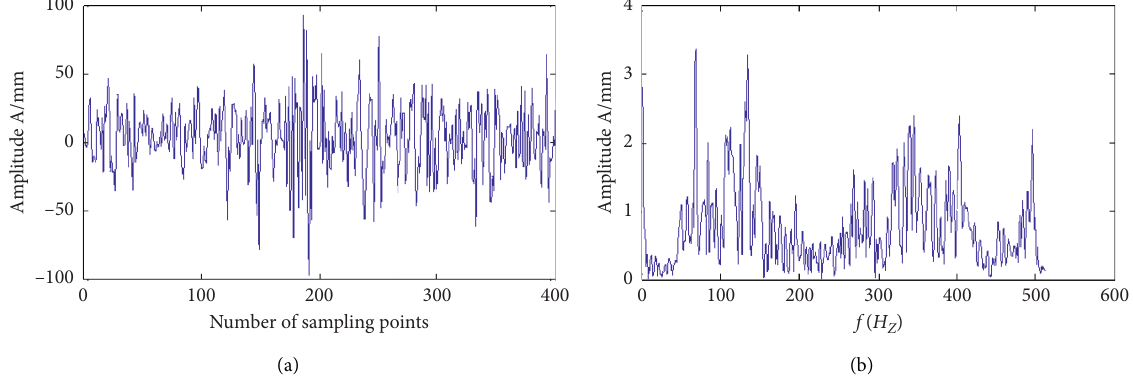
Figure 15: Original signal. (a) Time-domain waveform of the original signal and (b) original signal spectrum.